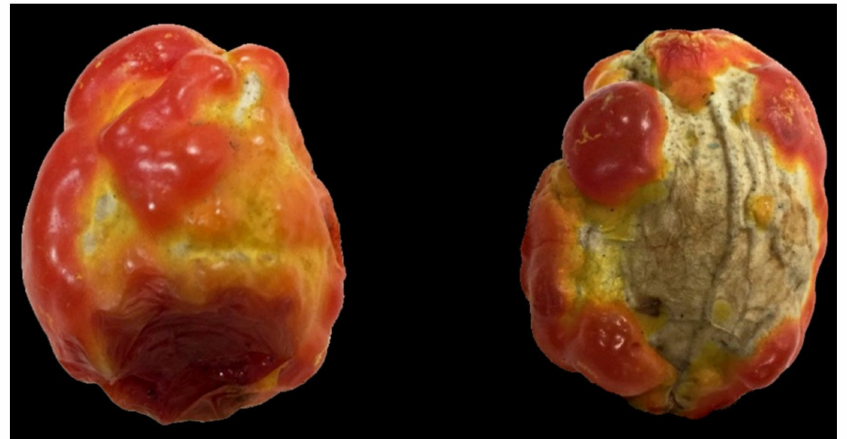
Figure 11. Large necrotic and depressed areas on fruits caused by Cucumber mosaic virus. The most destructive symptom is lethal necrosis, caused by the necrogenic strain (CMV N ), which leads to the decay and death of the plant within 2–3 weeks from infection. In this case, yellow areas between the secondary veins of the young leaves appear, which rapidly necrotize; then, leaves appear rolled downwards, leading to whole plant wilting starting from the vegetative apex